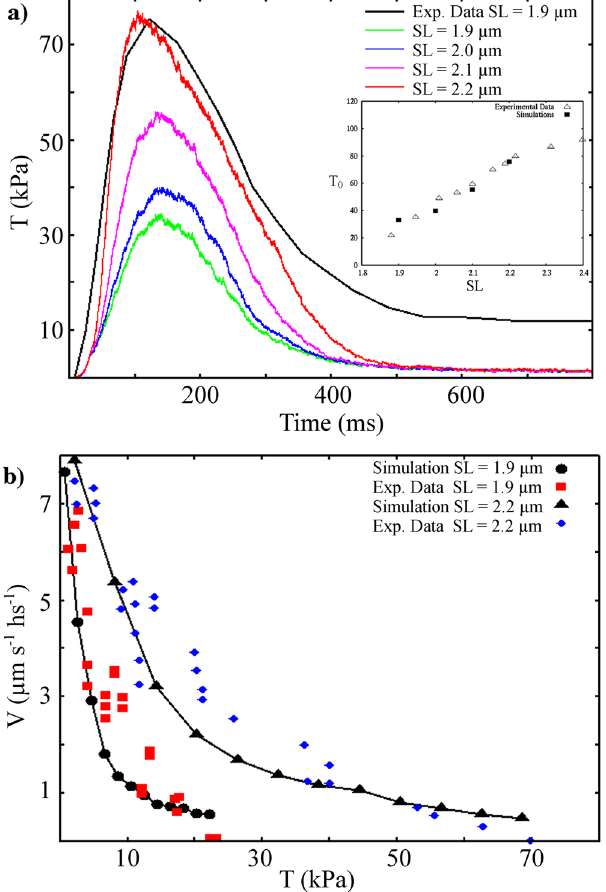
Figure 2. Simulations of isometric and isotonic twitches. Upper: Simulation of the tension generated during a physiological [Ca 2 + ] transient in isometric conditions, at different SLs. The experimental time transient at SL = 2.2 µ m (black line) is scaled to the simulated maximum tension at the same SL (red line). Simulated maximum active tensions vs . SLs are shown in the inset and compared with experimental data (simulations, filled squares; experimental data, empty triangles). Lower: A steady velocity of contraction is reached under isotonic conditions imposed near the maximum tension of a twitch. The simulated force–velocity curves (black dots, SL = 1.9 µ m; black triangles, SL = 2.2 µ m; and lines) quantitatively fit the experimental data, at two different SLs, without modifying the mechanokinetics properties of the motors. All experimental data are from Caremani et al . 10